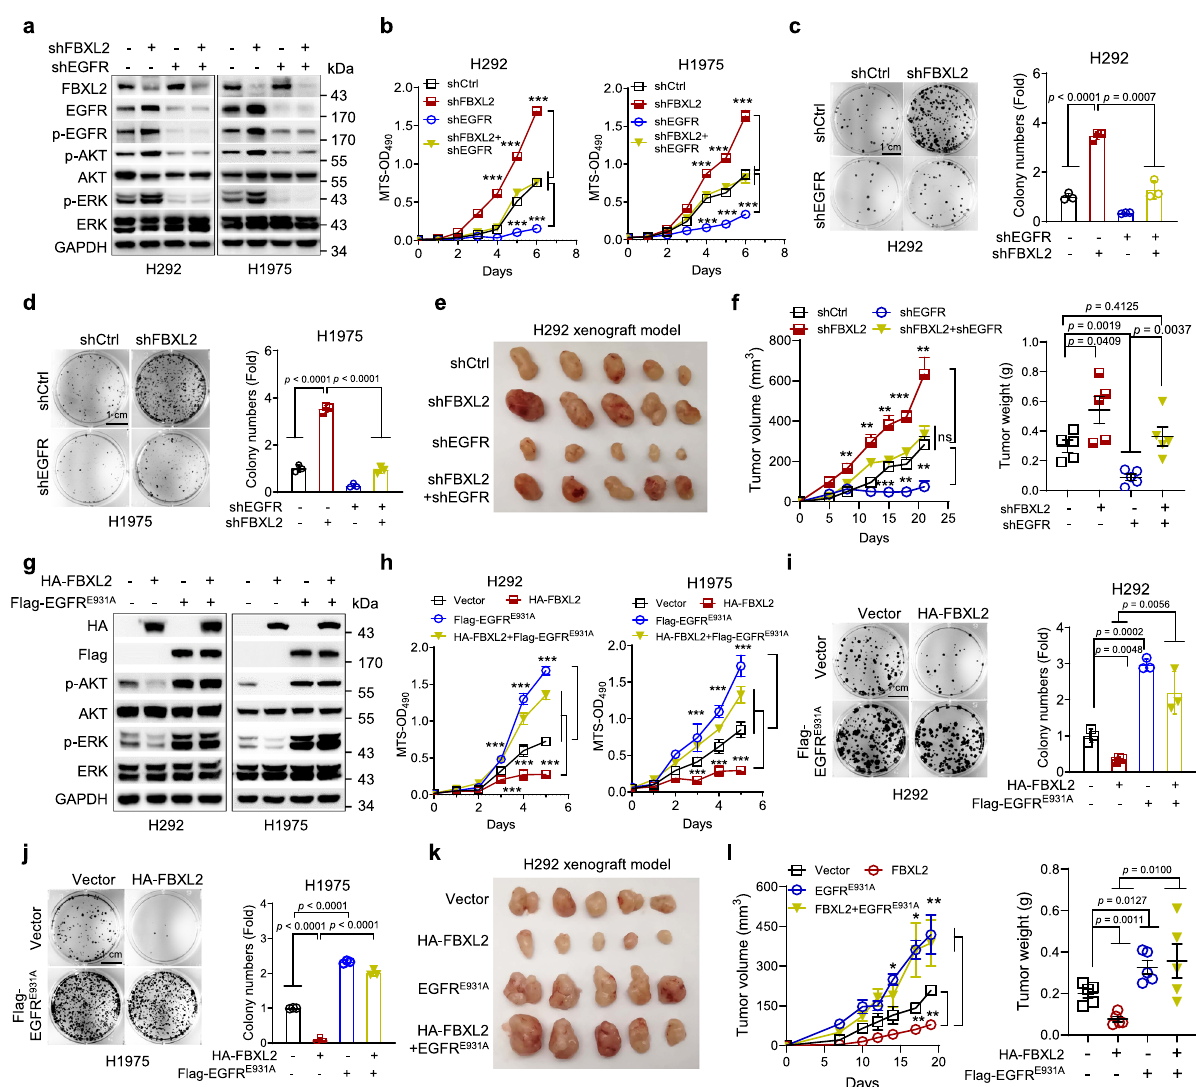
Fig. 4 FBXL2 inhibits NSCLC growth via downregulation of EGFR expression. H292 or H1975 cells stably expressing either shFBXL2 or shEGFR, or both were subjected to a Western blot analyses, b MTS assays, or c , d colony formation assays. Three independent experiments were performed. Data were presented as means ± SD. e , f H292 cells stably expressing either shFBXL2 or shEGFR, or both were subjected to xenograft tumor growth assays ( n = 5/ group). Mice were euthanized by day 21 after inoculation and tumors were dissected and photographed. Tumor growth curves and tumor weight were presented as means ± SEM. H292 or H1975 cells stably expressing HA-FBXL2 or Flag-EGFR E931A , or both were subjected to g Western blot analyses, h MTS assays, or i , j colony formation assays. Three independent experiments were performed. Data were presented as means± SD. k , l H292 cells stably expressing either HA-FBXL2 or Flag-EGFR E931A , or both were subjected to xenograft tumor growth assays ( n = 5/group). Mice were euthanized by day 19 after inoculation and tumors were dissected and photographed. Tumor growth curves and tumor weight were presented as means ± SEM. * p <